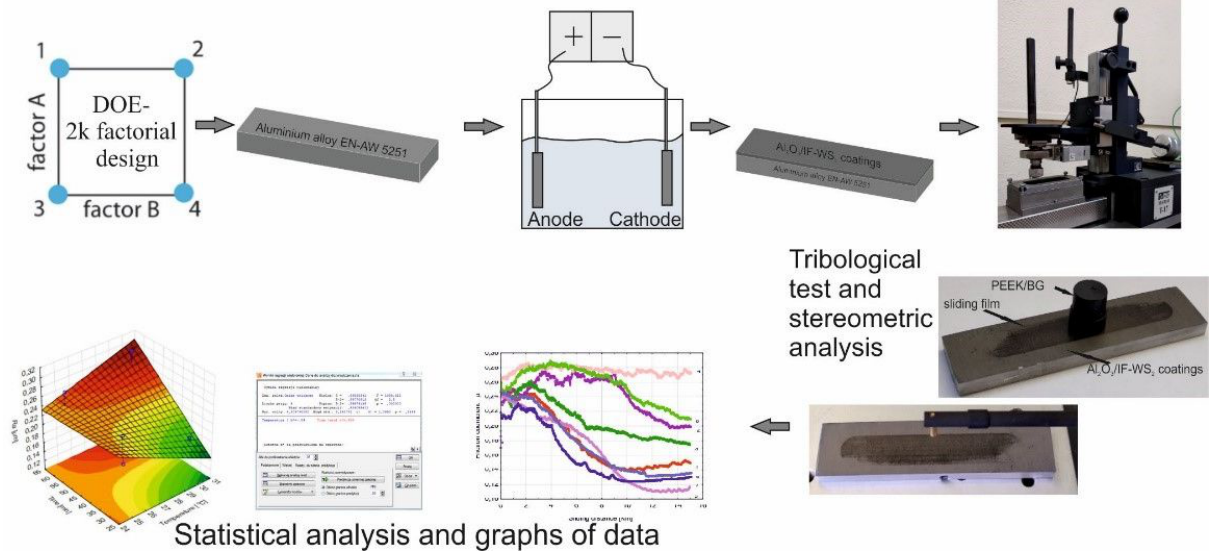
Figure 1: Framework structure of this